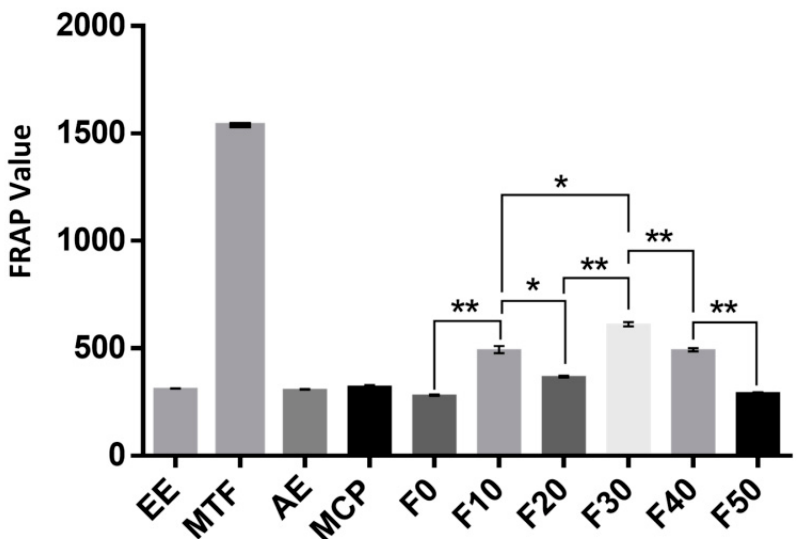
Figure 4. Results of the FRAP method. The in vitro antioxidant activity of MCB is expressed by FRAP values, followed by F30, F10, F40 and F20. EE: alcohol extract, AE: aqueous extract, MTF: total flavonoids, MCP: crude polysaccharides. “*” and “**” mean p < 0.01 and p < 0.05, respectively. Data are expressed as mean ± standard deviation ( n = 5).